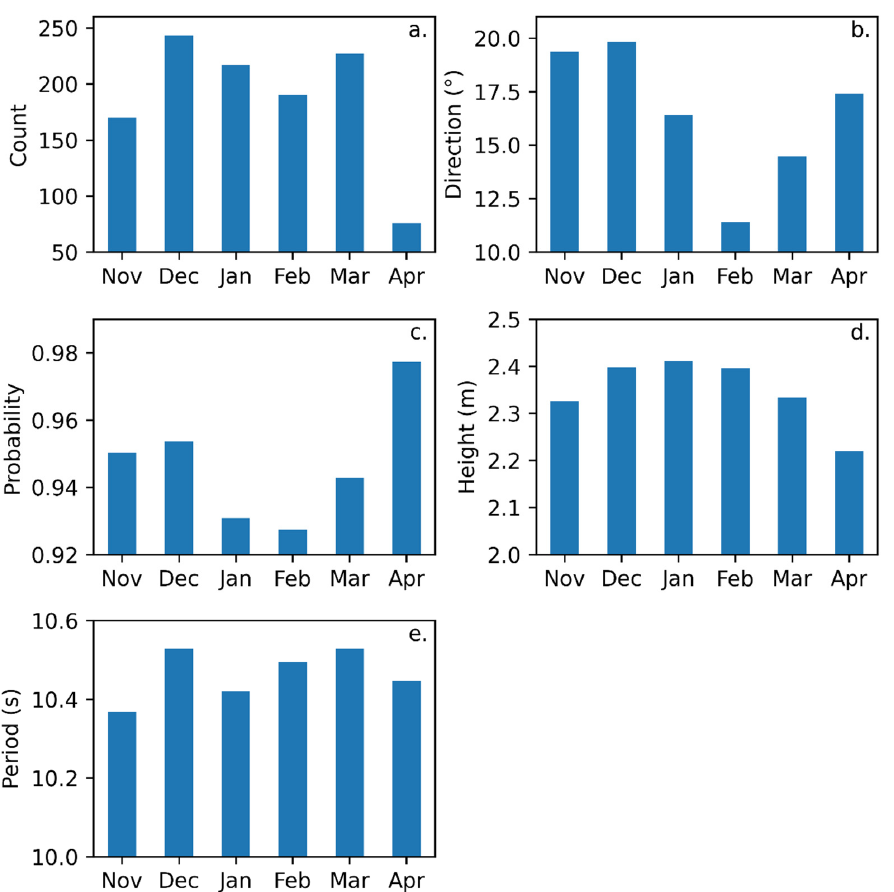
Figure 8. ( a ). Monthly count of north swell cluster (Figure 7a) days for the study period. Daily spatially averaged data for the eastern Caribbean for north swell cluster days, averaged by month, of swell ( b ). direction, ( c ). probability, ( d ). height, and ( e ). period.